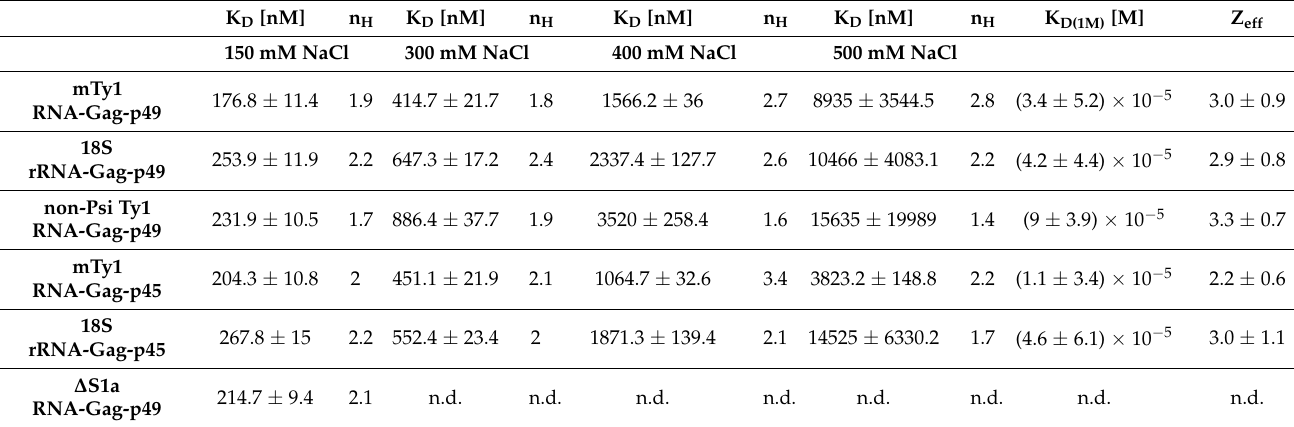
experiments. n.d.: not